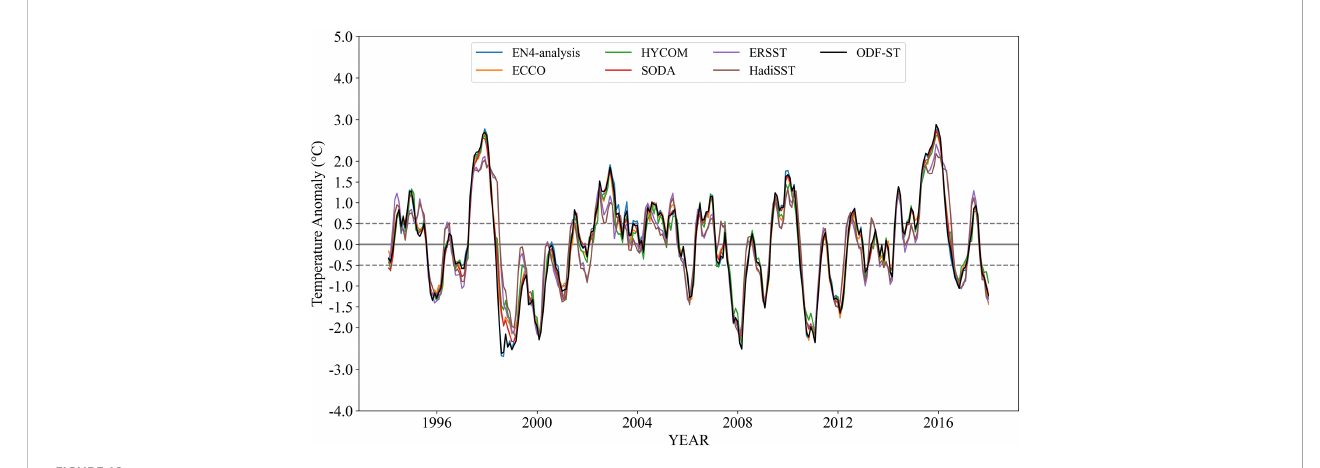
FIGURE 12 ENSO index time series in the Nino3.4 region of various